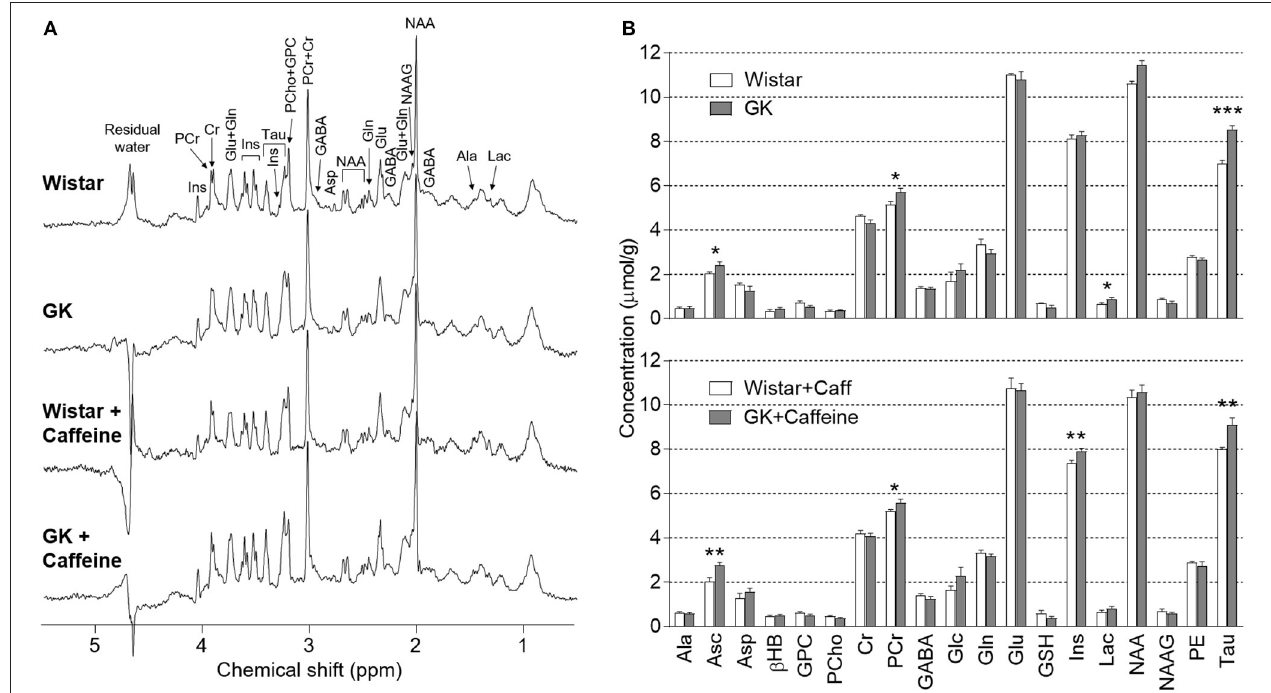
FIGURE 3 | Diabetes-induced metabolic alterations persisted upon caffeine treatment. (A) shows representative 1 H spectra acquired in vivo at 9.4T from the dorsal hippocampus rats under normoglycaemia. An increase of taurine resonances at 3.25 and 3.42 ppm in the spectra from GK rats is clearly visible. The spectra were measured by the SPECIAL sequence with echo time of 2.8ms, repetition time of 4s, 640 scans and in a volume of 18 µ L. For resolution enhancement, a shifted Gaussian function (gf = 0.12 and gsf = 0.05) was applied before Fourrier transformation. Zero-phase but not baseline was corrected. (B) shows mean metabolite concentrations in the hippocampus of Wistar ( n = 6), GK ( n = 8), caffeine-treated Wistar ( n = 7) and caffeine-treated GK ( n = 8) rats, at plasma glucose below 8 mmol/L. None of the metabolite concentrations showed caffeine-diabetes interaction. Results from post-hoc tests on metabolite levels after significant diabetes effect or caffeine-diabetes interaction are represented by * P < 0.05, ** P < 0.01, and *** P < 0.001 for GK vs. Wistar in the respective treatment